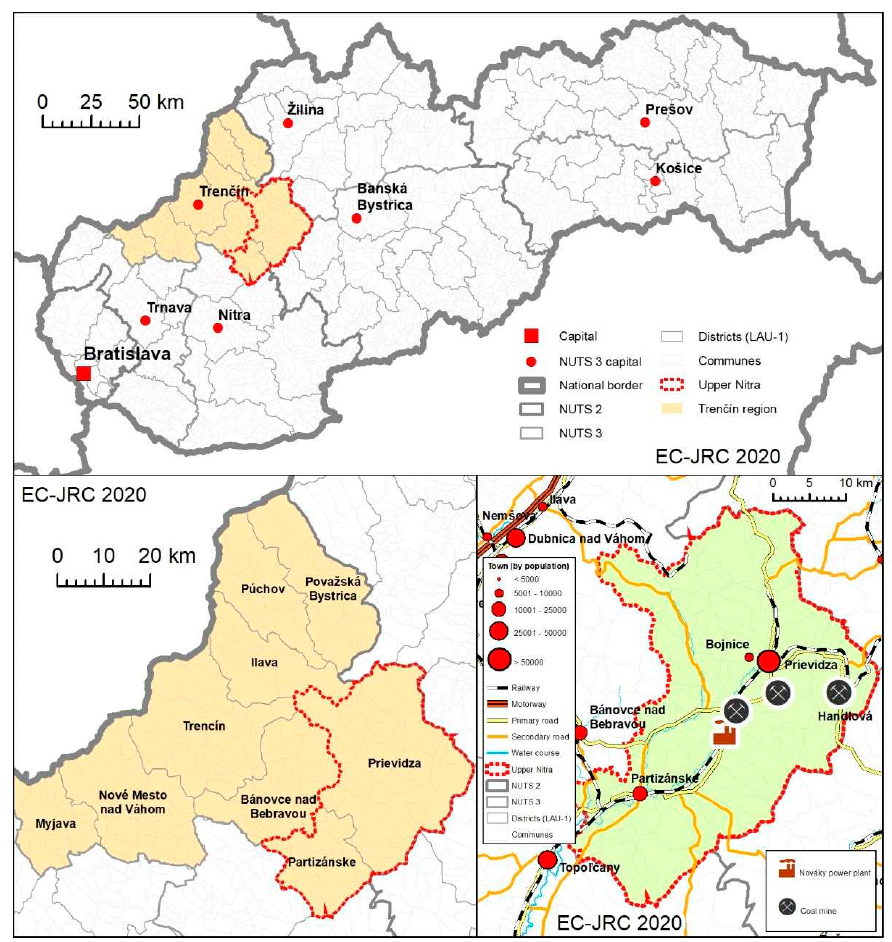
Figure 2. Location of Upper Nitra and coal mines.